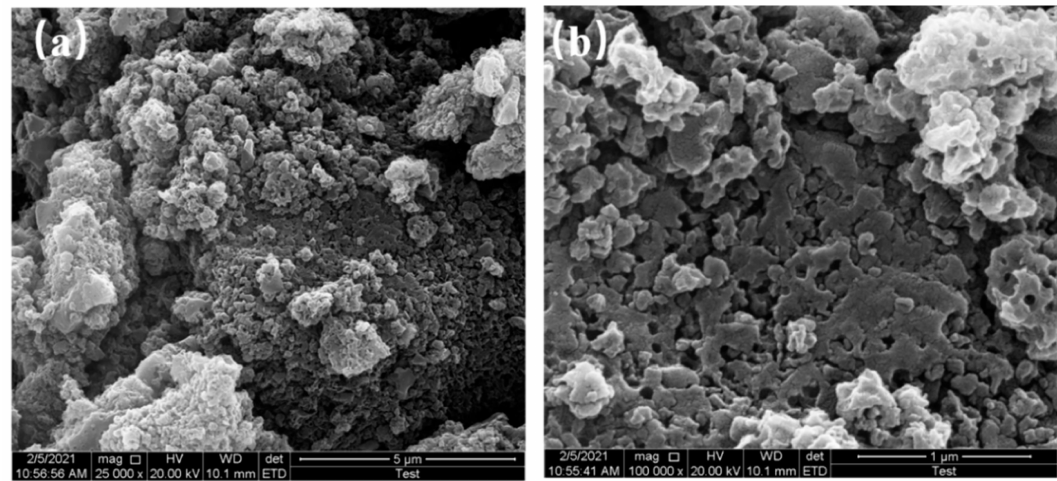
Figure 5. SEM images of 750 ◦ C at ( a ) 5 µ m resolution, ( b ) 1 µ m